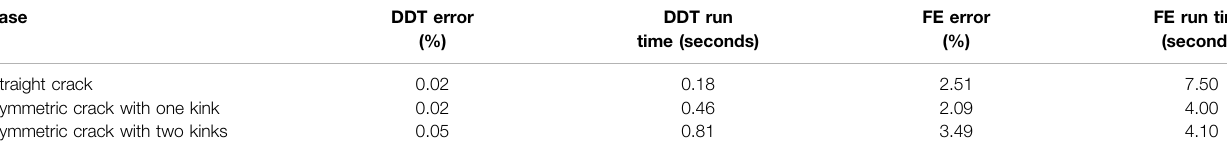
TABLE 3 | Comparison of literature values, DDT results, and FE outputs for serval crack con fi